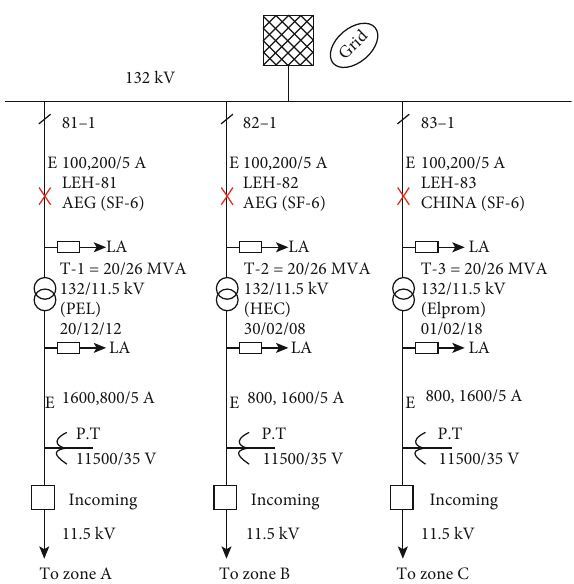
Figure 1: 132kV grid station installed at Layyah, Pakistan [26].